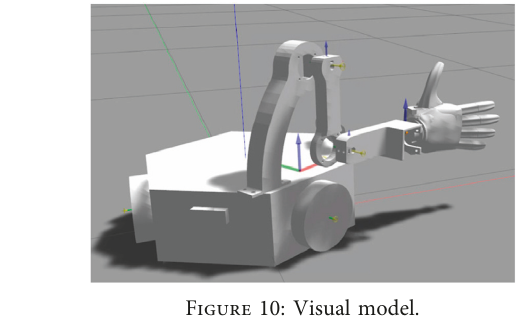
Figure 10: Visual model.